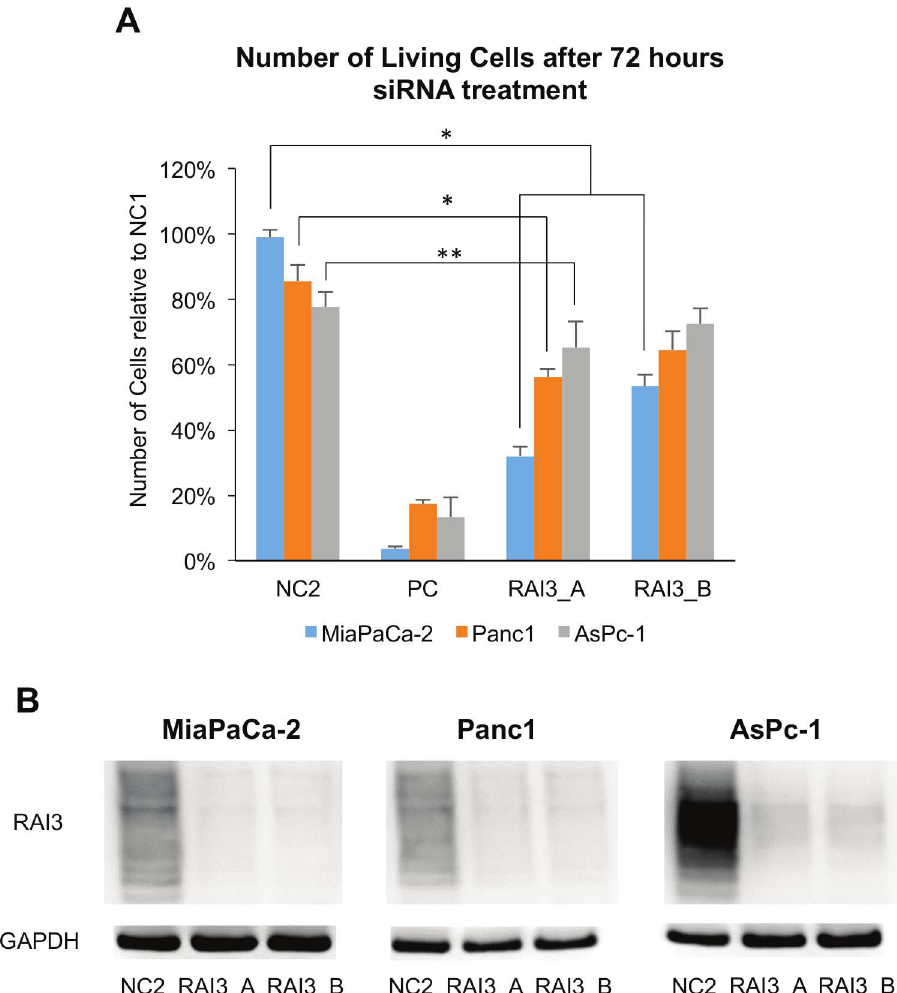
Fig 4. Effect of treatment with GPRC5a-siRNA over 72 hours. A: Number of living cells in negative controls (NC; 1: Medium, 2: non-sense-siRNA), positive control (PC; eg5-siRNA) and knock-down with two different GPRC5a-siRNA (RAI3_A and RAI3_B). Statistically significantdifferences in t-test are marked with * for P-Value < 0.001 and ** for P-Value < 0.05; B: Western blot and quantitative real time PCR with RAI3 antibody confirms the successful knock-down using siRNA (for functionalanalysisthe GPRC5A.1 siRNA was chosen)(S1 Fig). (n =